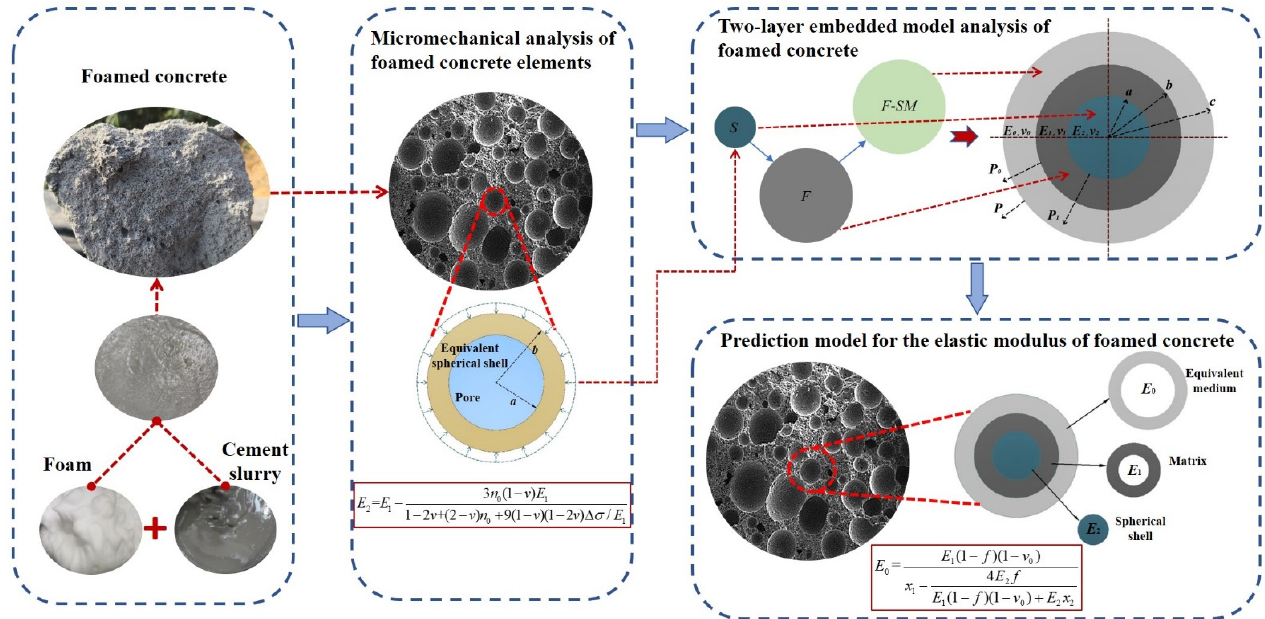
Figure 6. Schematic of the calculation of a single inclusion in foamed concrete.